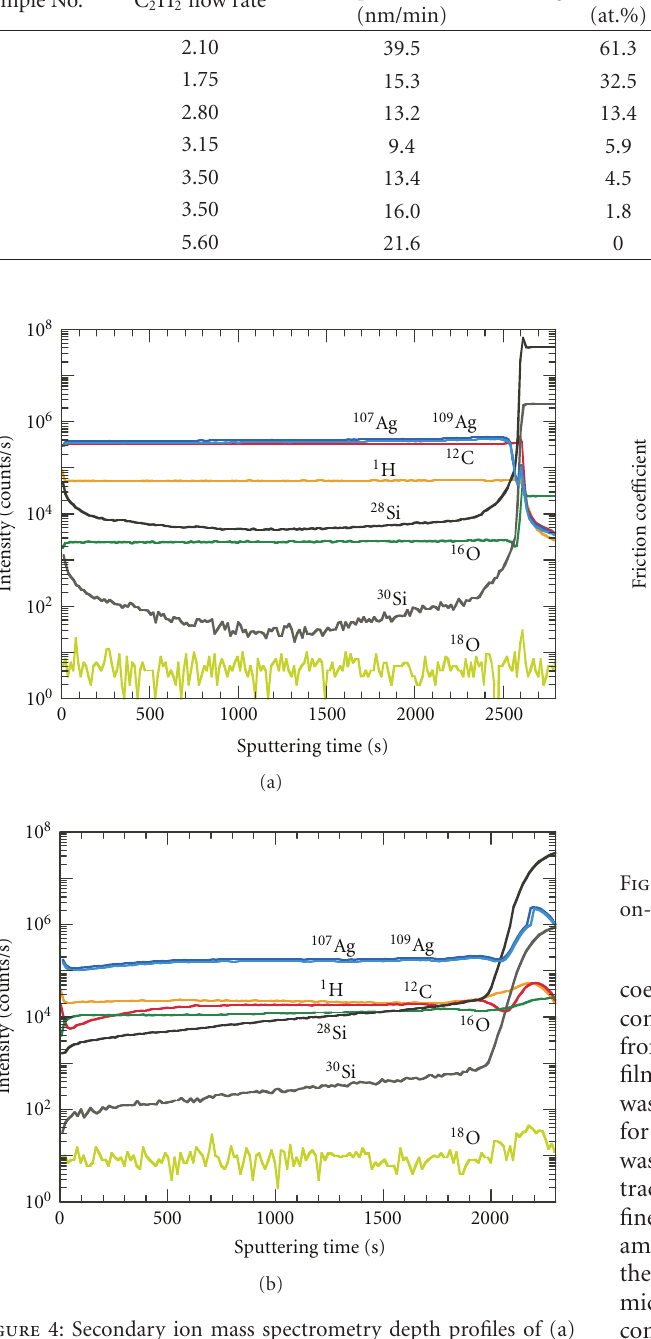
Table 1: Raman spectroscopy data of Ag-DLC films with various amounts of silver. Sample No.